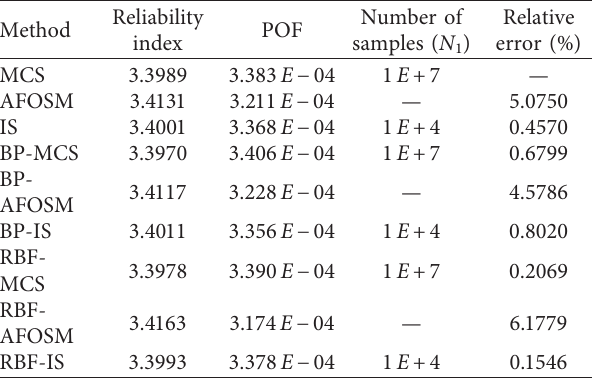
Figure 7: Comparison between the original LSF values and the predicted LSF values by ANNs. (a) The LSF value at testing sample for an ANN sample size of 100. (b) The LSF value of the sixth testing sample point relative to change in the ANN sample data size. Table 5: Comparison of the reliability index and POF from dif- ferent reliability analysis methods with an ANN sample size of 100.